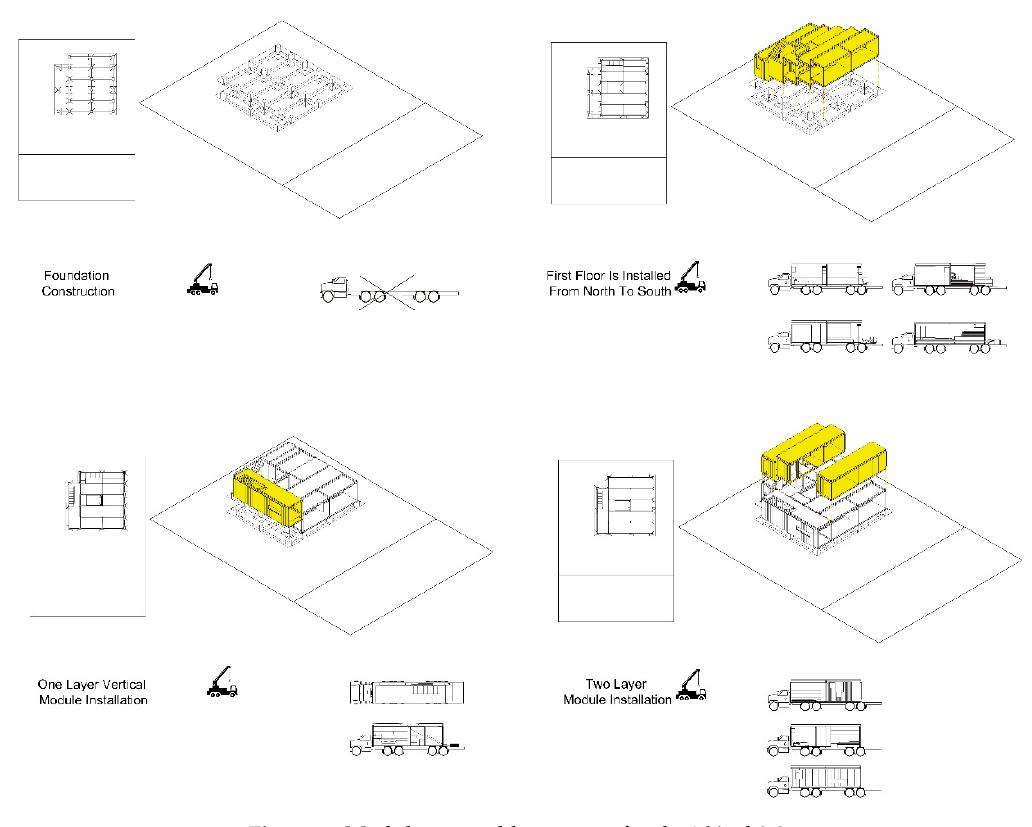
Figure 2. Modular assembly strategy for the i-Yard 2.0.